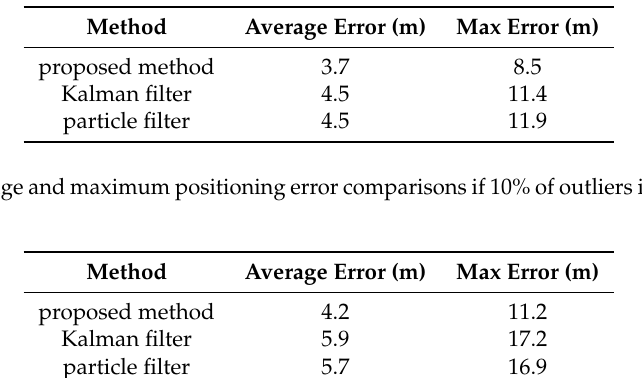
Table 4. The average and maximum positioning error comparisons if 5% of outliers in PDR positioning are added.